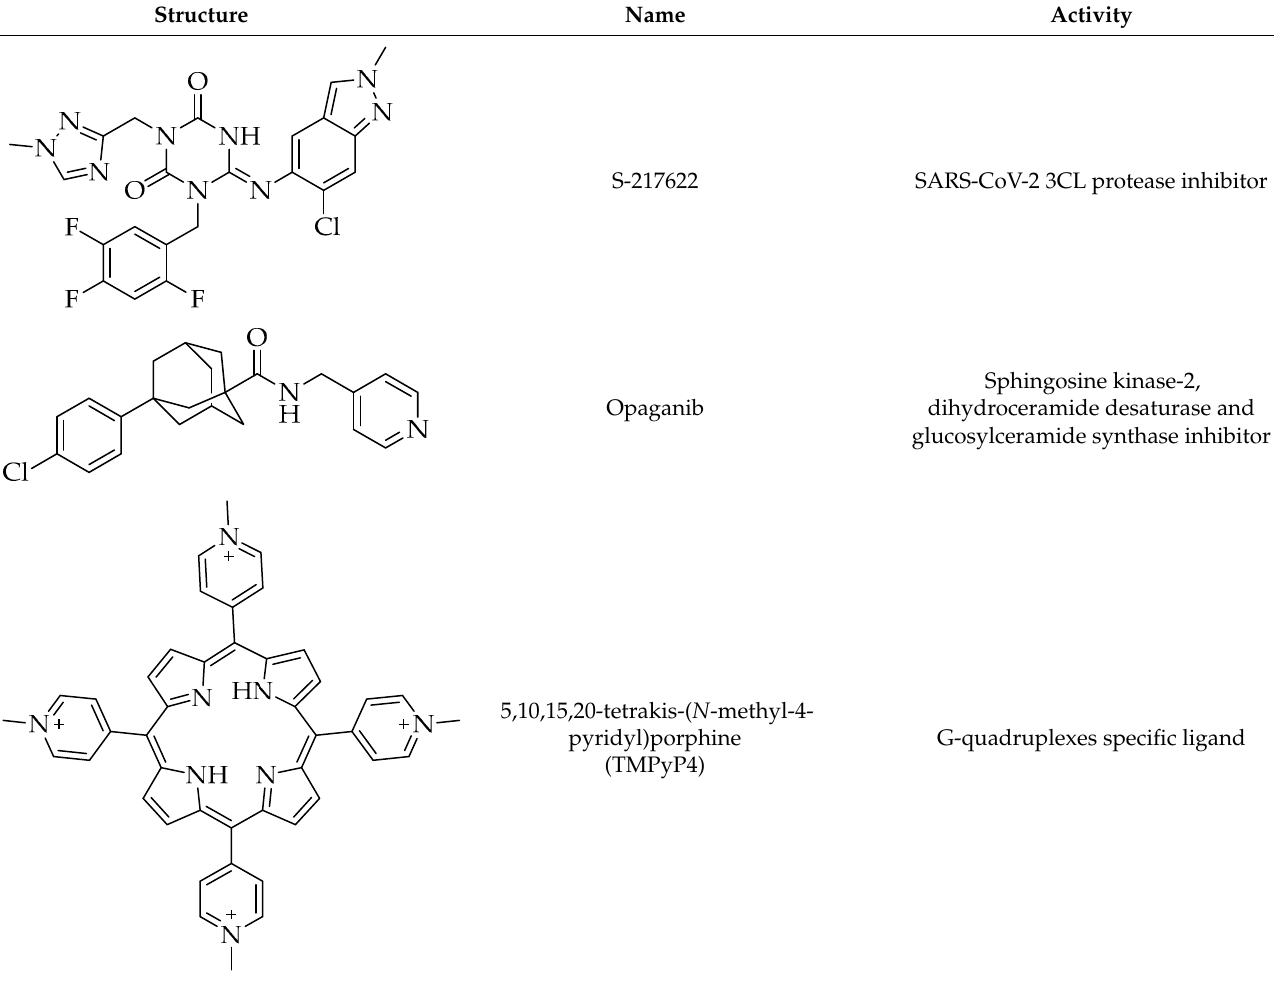
Table 2. New drugs for the treatment of COVID-19. Structure